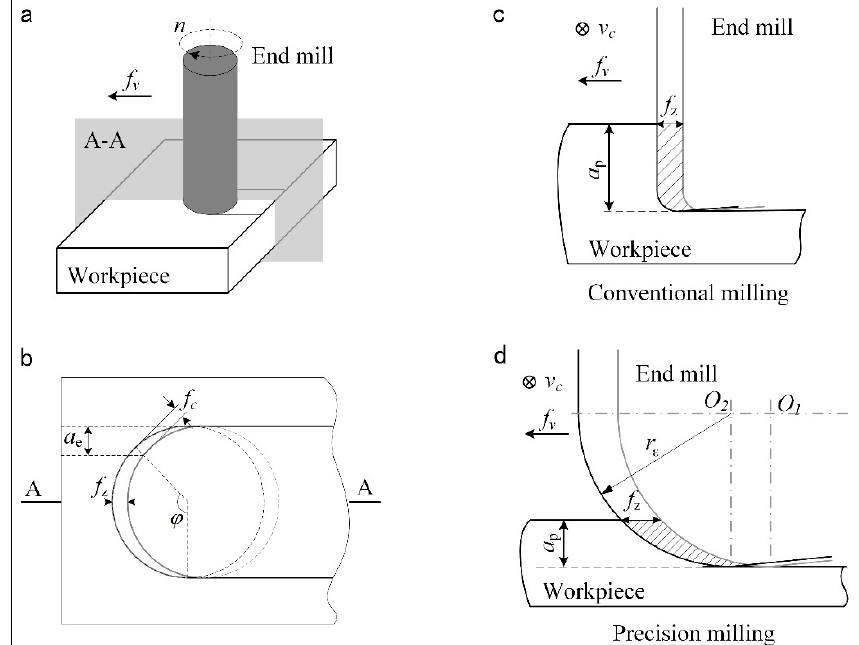
Figure 1. Schematic of groove milling from ( a ) side view, ( b ) top view and zoom in of cutting zone in ( c ) conventional milling and ( d ) micro precision milling.